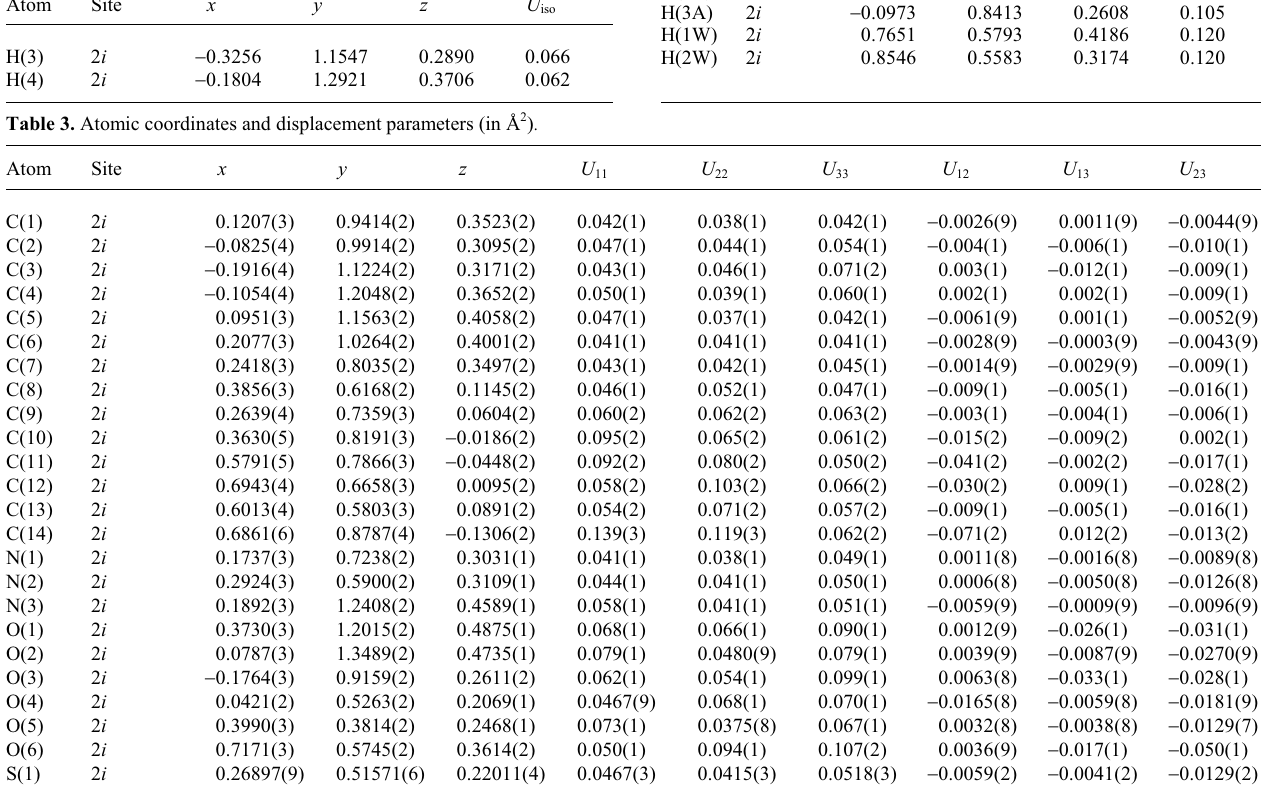
Table 2. Atomic coordinates and displacement parameters (in Å 2 ) .